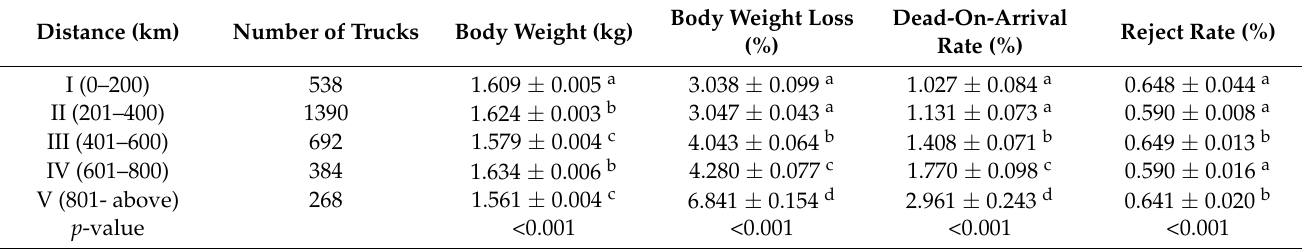
transportation distances between the farms and the slaughterhouse, are presented in Table 4. Each evaluated variable was significantly affected by the transport distance ( p < 0.001). The body weight loss, DOA rate, and reject rate were lower for shorter transportation distances, while all the evaluated parameters were higher when the transportation distance increased. Table 4. Average body weight, body weight loss, dead-on-arrival rate, and reject rate according to transportation distance (mean ± SEM).